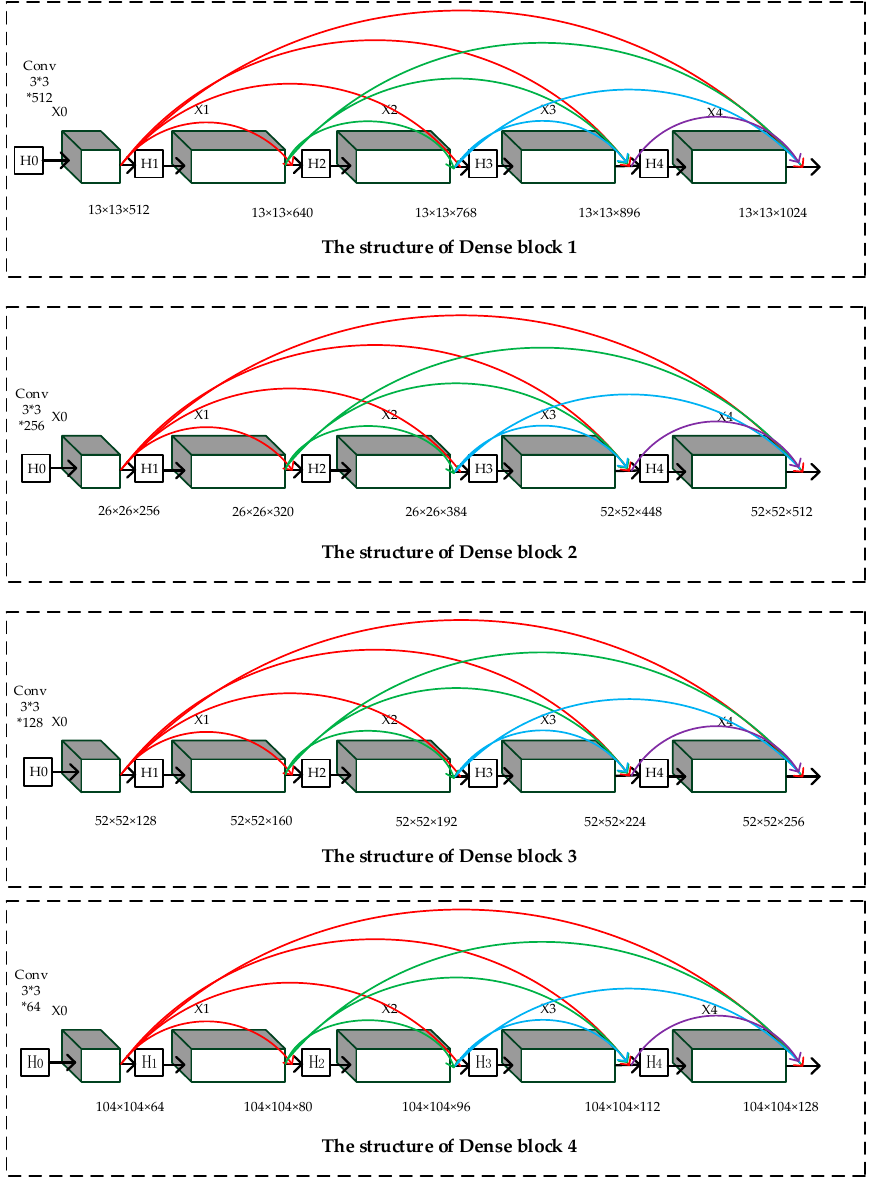
Figure 6. The structure of Dense blocks.